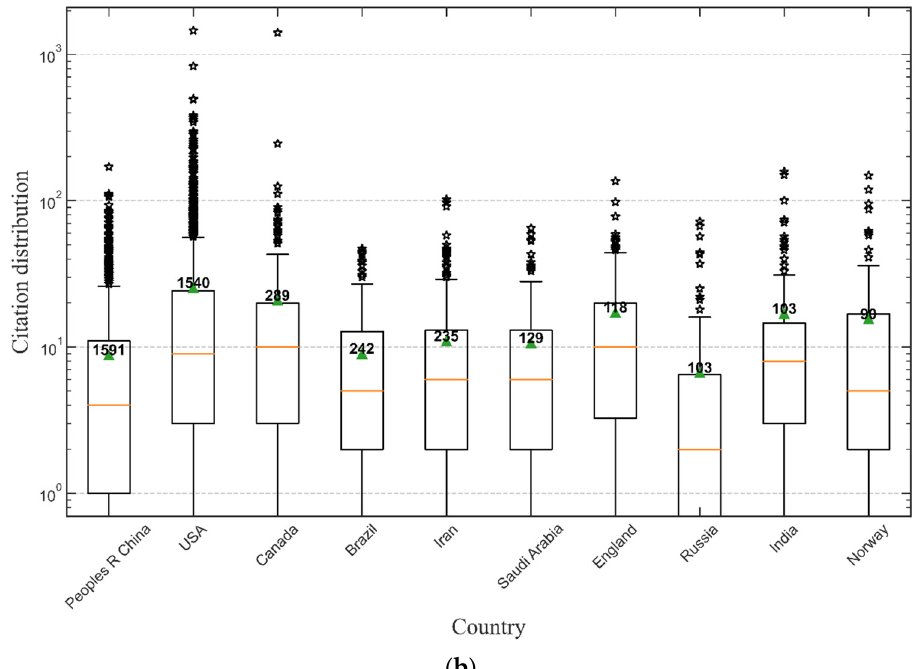
Figure 11. ( a ) The giant connected component of country/region collaboration network generated by VOSviewer. ( b ) Top 10 most scientific influence corresponding country/region. The asterisk in figure indicates the outliers.